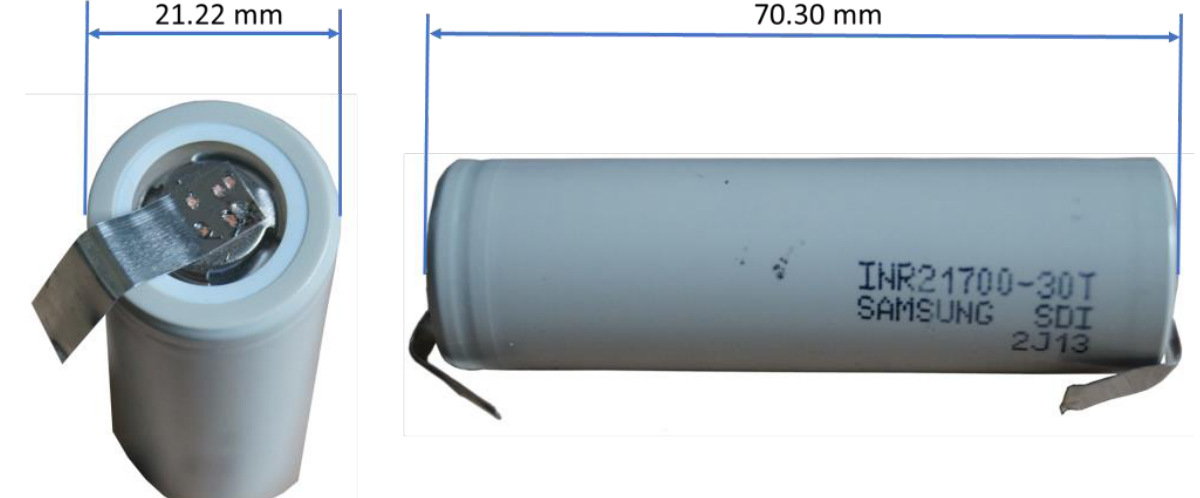
Figure 1. Samsung INR21700-30T Li-Ion cell, used within this study.